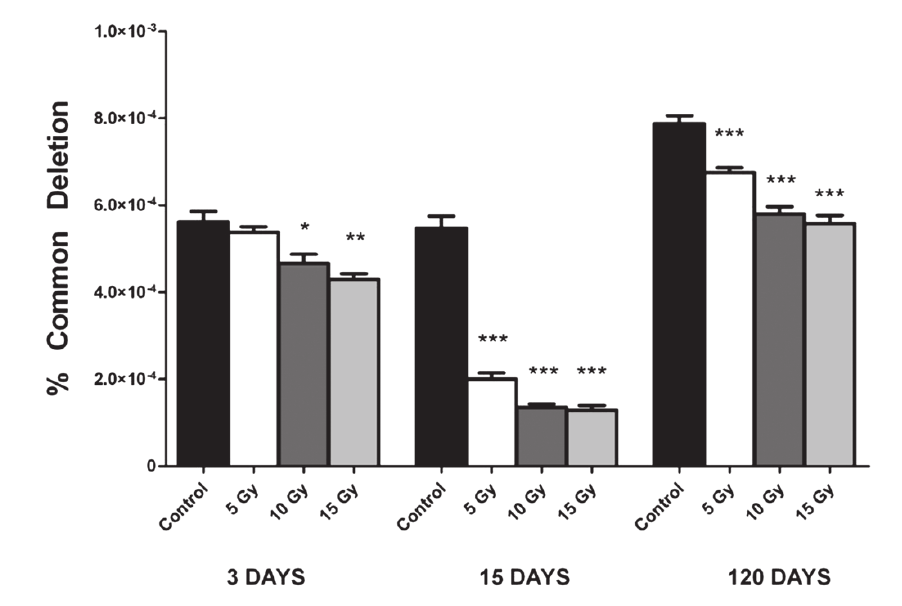
Figure 1 - Quantification by Real Time PCR of CD levels in cardiac tissue of rats irradiated with doses of 5, 10 or 15 Gy and their controls at different times after irradiation. The differences between the irradiated groups and its control were analyzed with analysis of variance (ANOVA) and the Tukey-Kramer post hoc test. Error bars represent standard deviation (SD). Statistical significance was accepted when ( P < 0.05 *), ** ( P < 0.01) and *** ( P <